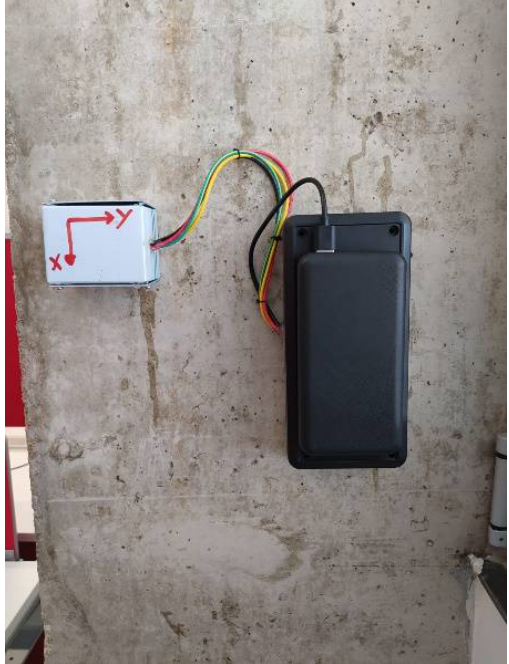
Figure 12. Installed sensor and its acceleration reference system.